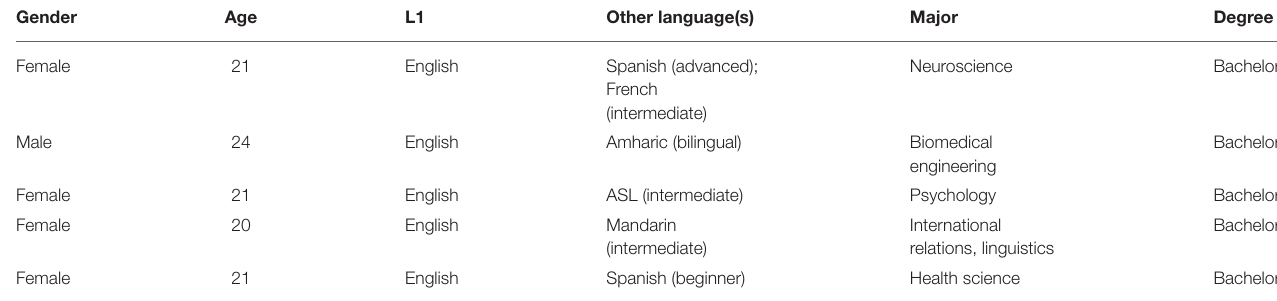
TABLE 2 | L1 English speakers’ biographical information.